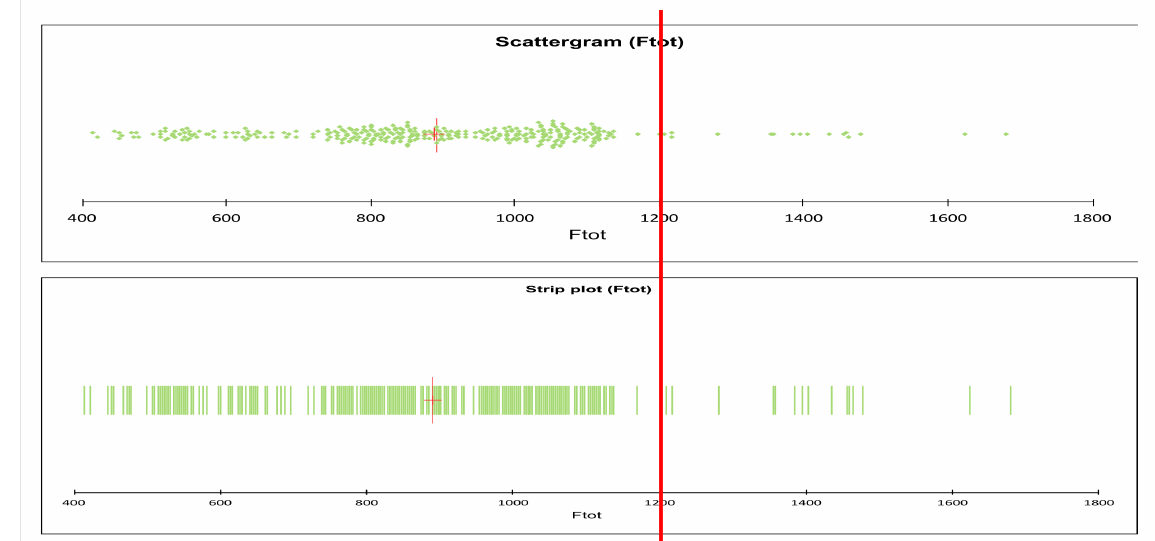
Figure 19. Variation of the daily water consumption of the campus–Events with consumption exceeding 1200 m 3 (average water consumption + 1.5 standard deviation) could be related to leakage, (line in the red color).